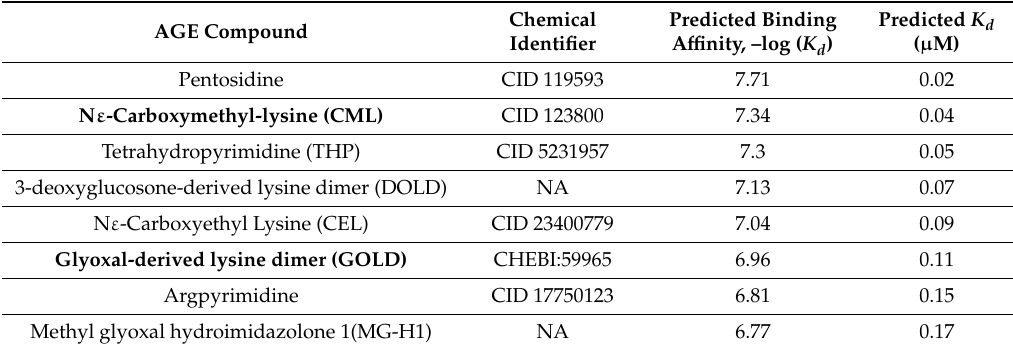
Table 1. Predicted binding a ffi nities of advance glycation end-products (AGEs). CID: PubChem; CSID: ChemSpider; CHEBI: Chemical Entities of Biological Interest (EMBL-EBI), NA: Not